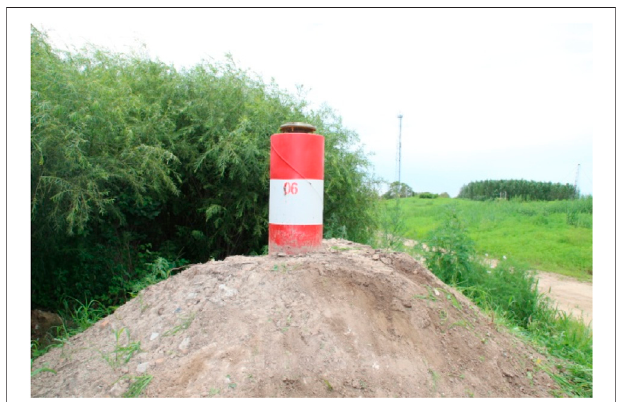
FIGURE 3 | Marker-stake for surface displacement